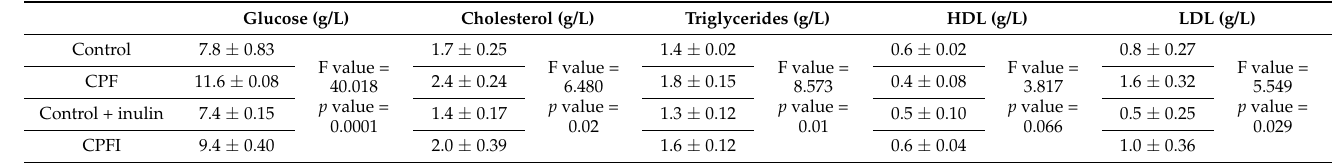
Table 2. Effects of exposure to CPF and inulin on blood sugar (A) and lipid (B) levels in dams. Blood glucose, total cholesterol (TC), plasma triglycerides (TG), high density lipoproteins (HDL) or low density lipoproteins (LDL) were measured in plasma. The values are expressed as mean ± SEM ( n = 4). Significantly different ( p < 0.05) using analysis of variance (ANOVA) and Tukey’s test. C: Control; CPF: Chlorpyrifos; CI: Control inulin; CPFI: Chlorpyrifos +